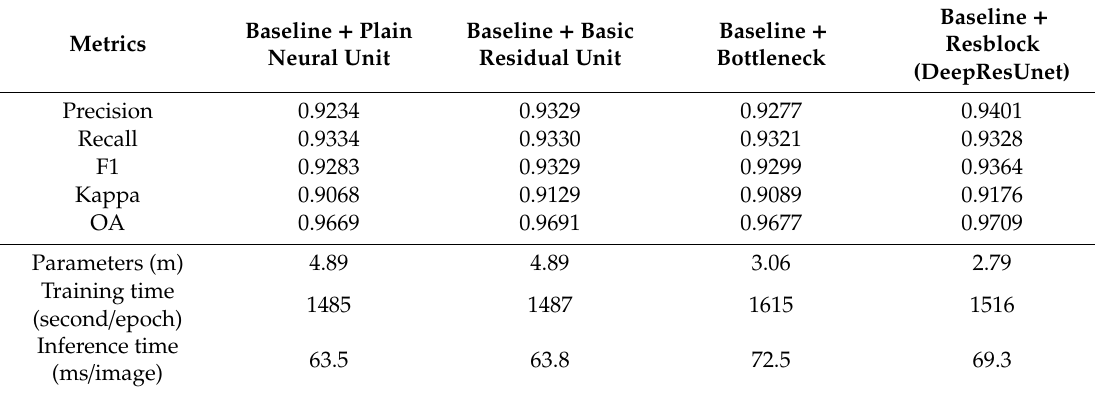
Table 3. Comparisons of building segmentation results and model complexity among the di ff erent variants of